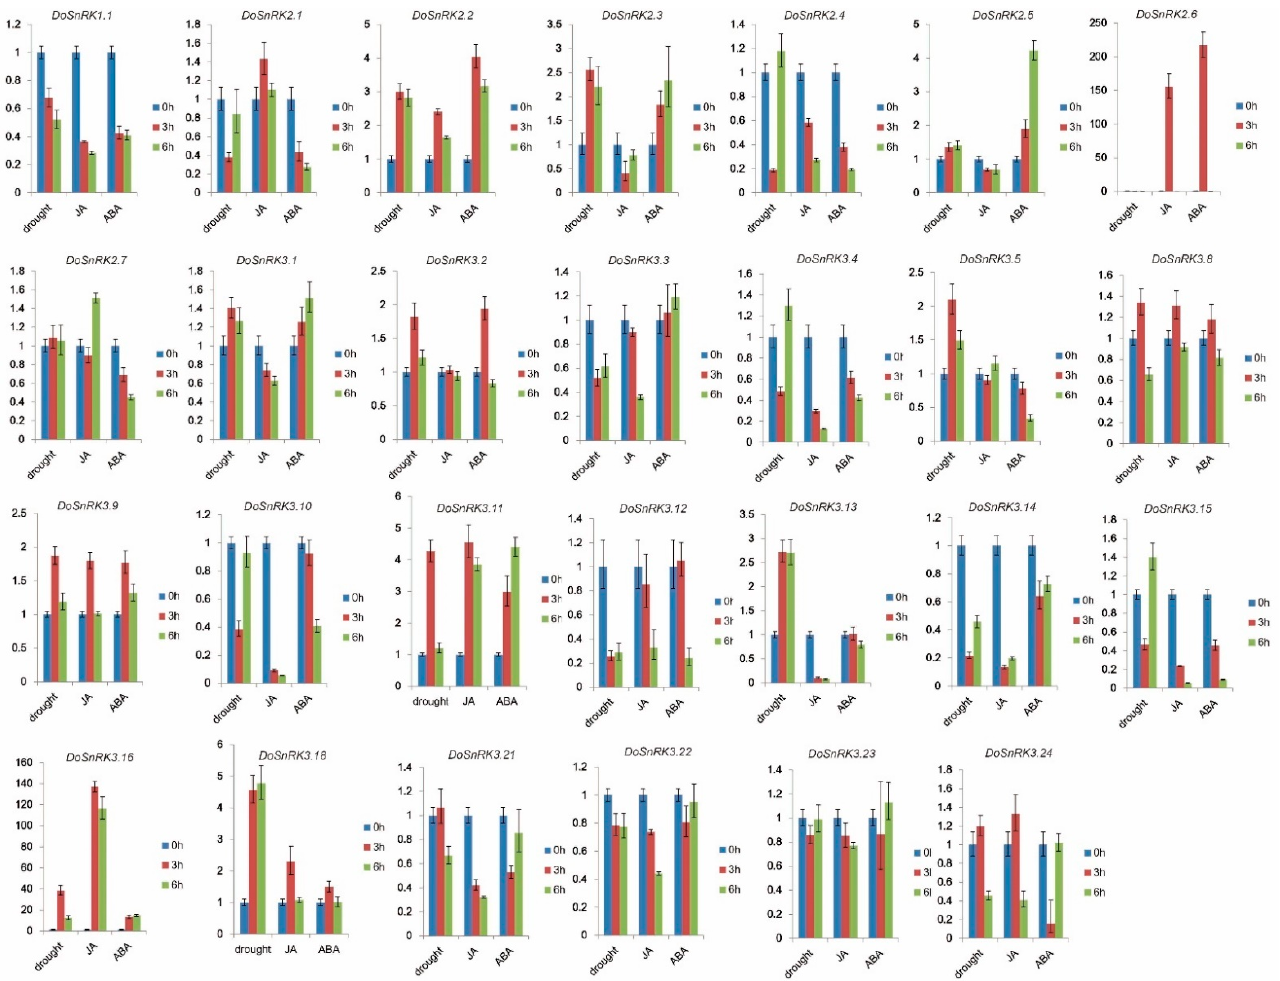
Figure 6. Expression levels of 27 DoSnRK genes under three treatments using qRT-PCR assays. The mock-treated leaves at the beginning (0 h) were used as the control to calculate the relative expression levels at 3 and 6 h after treatment. Each experiment was performed with at least three individual plants with three replications. The bars denote the standard deviation.